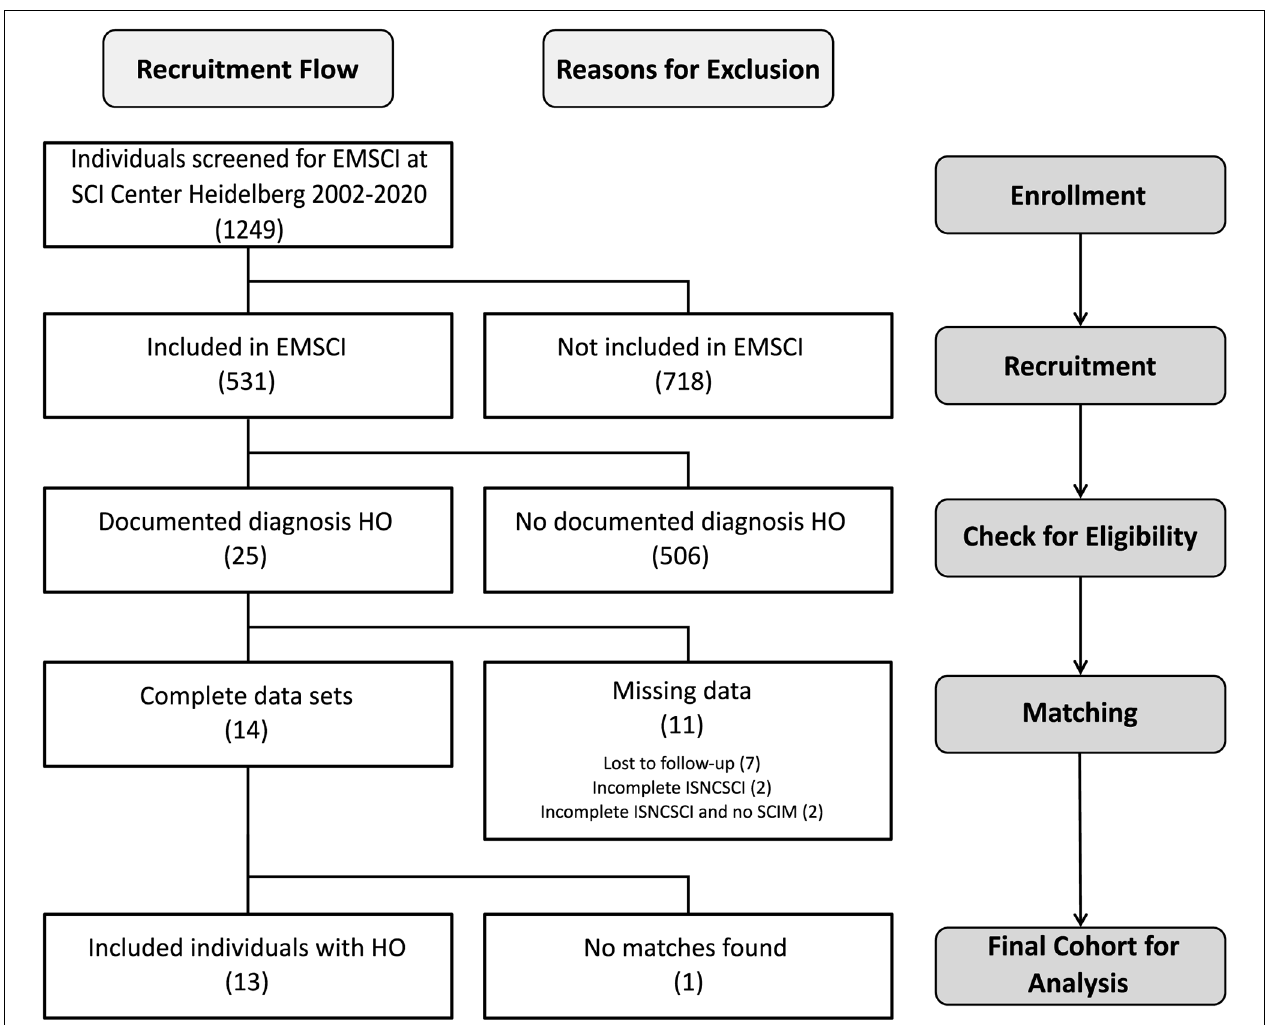
FIGURE 2 | Flow diagram of recruitment process at each stage of the study. Abbreviations: HO, heterotopic ossification; EMSCI, European Multicenter Study about Spinal Cord Injury; ISNCSCI, International Standards for Neurological Classification of Spinal Cord Injury; SCIM, spinal cord independence